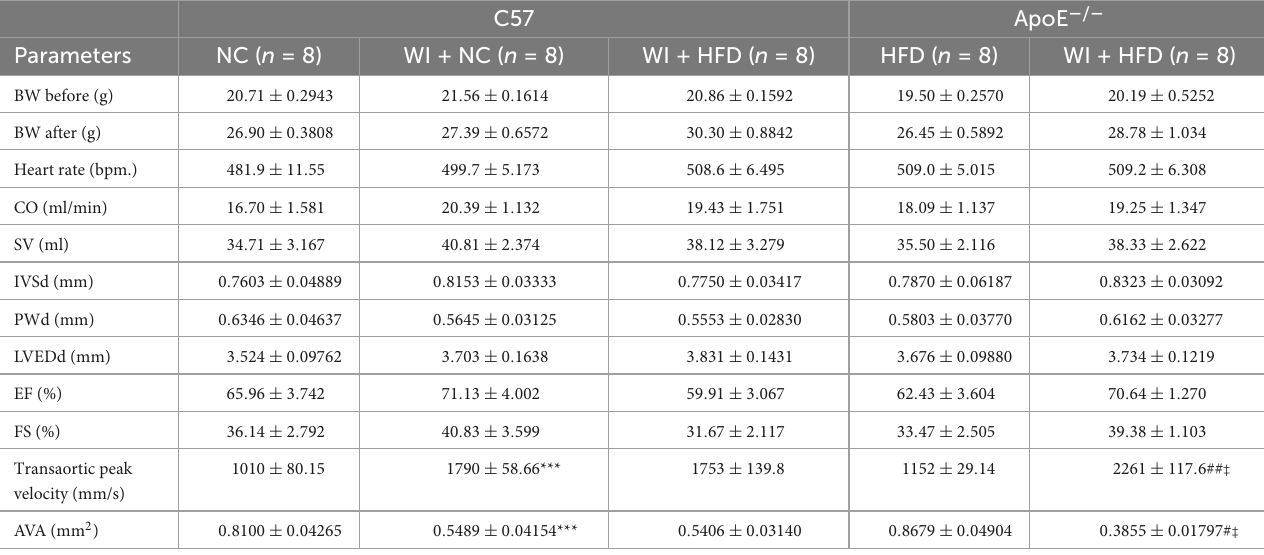
TABLE 1 Echocardiographic parameters in different groups of mice.